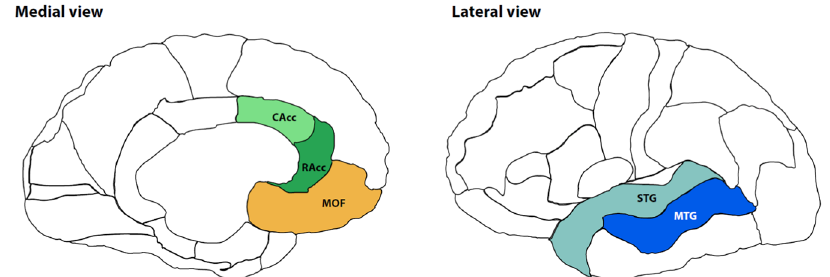
Figure 1. Regions of Interest (ROIs): medial orbitofrontal (MOF), caudal anterior cingulate cortex (CAcc), rostral anterior cingulate cortex (RAcc), superior temporal gyrus (STG), middle temporal gyrus (MTG). The left and right insula were excluded from further analyses due to frequent inadequate or complete failure of segmentation.